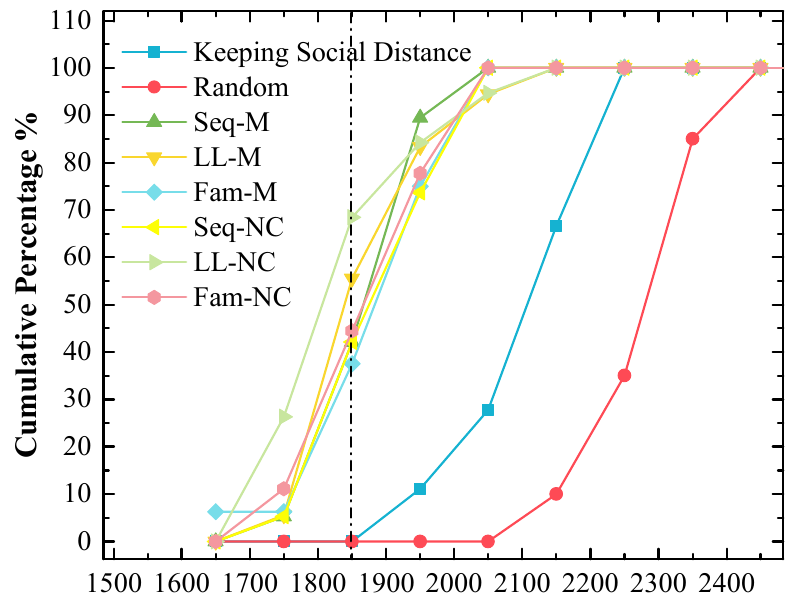
Figure 11. The cumulative frequency of cumulated confirmed numbers under different strategies in the 2nd scenario. The x-value of the dash line is 1850.